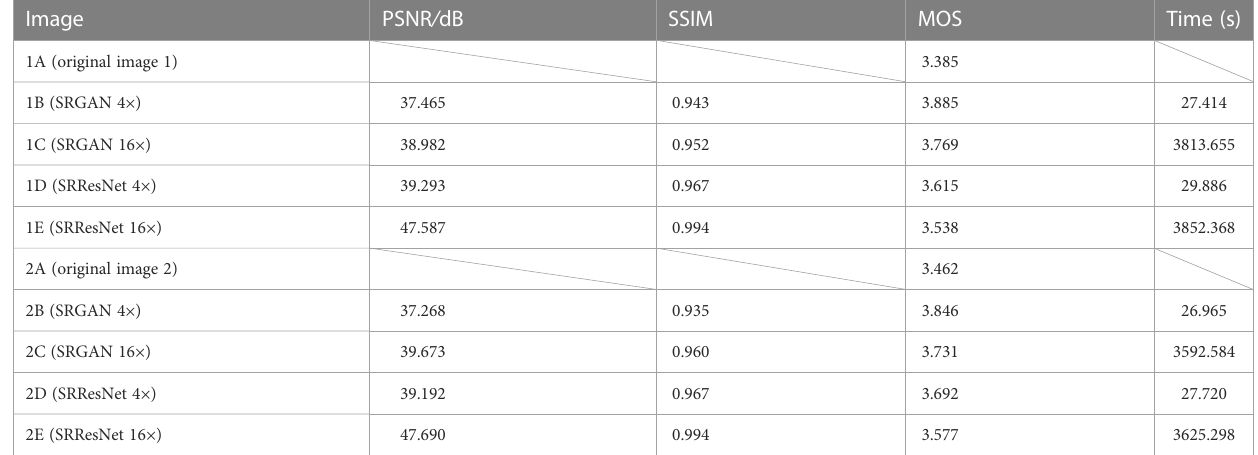
TABLE 1 Comparison of the quality evaluation indicators and time required for different reconstruction. Image PSNR /